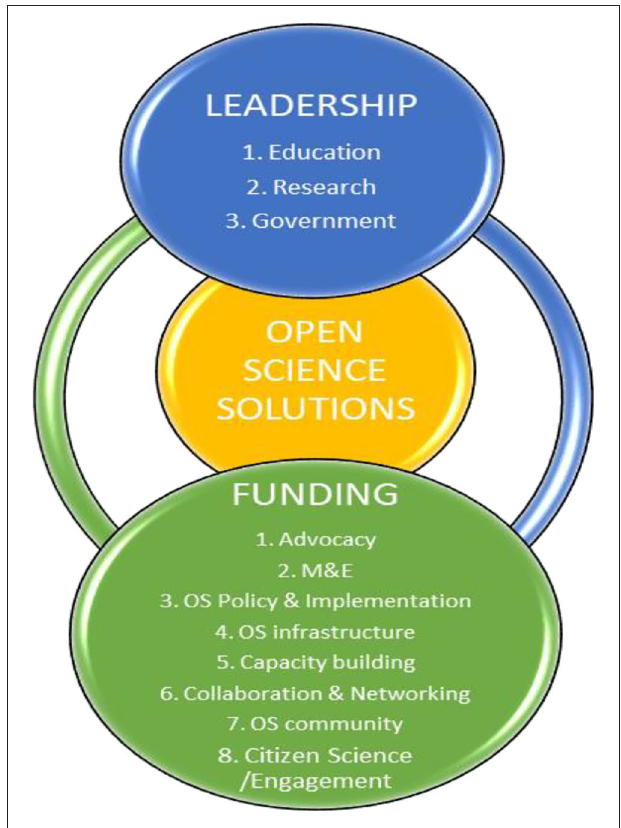
FIGURE 3 | Conceptual framework for creating open science solutions in Africa. M&E, monitoring and evaluation; OS, open